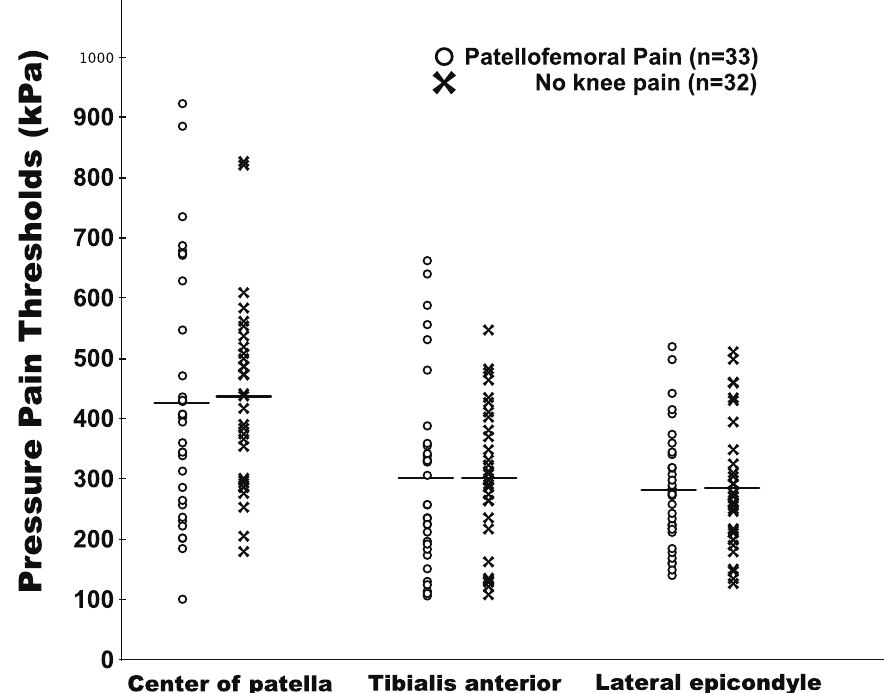
Fig 2. Mechanical PPTs at the three test sites before the conditioning